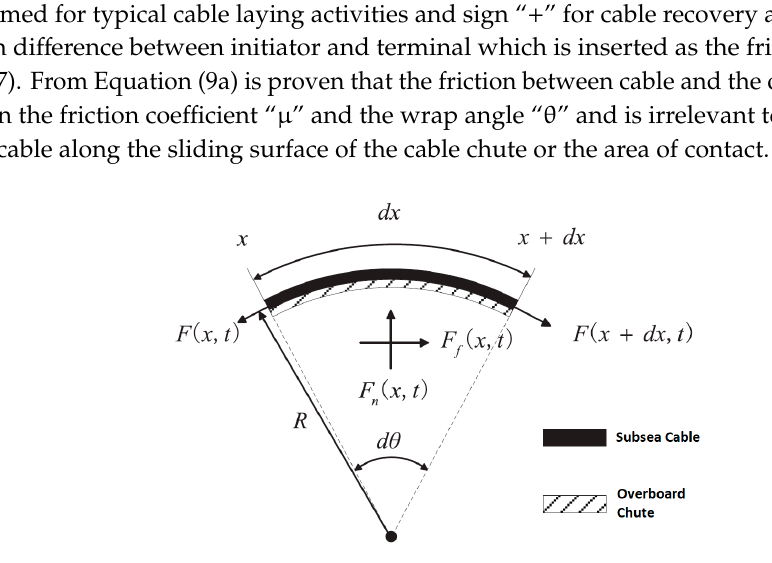
Figure 18. The force analysis of the cable infinitesimal element along the cable